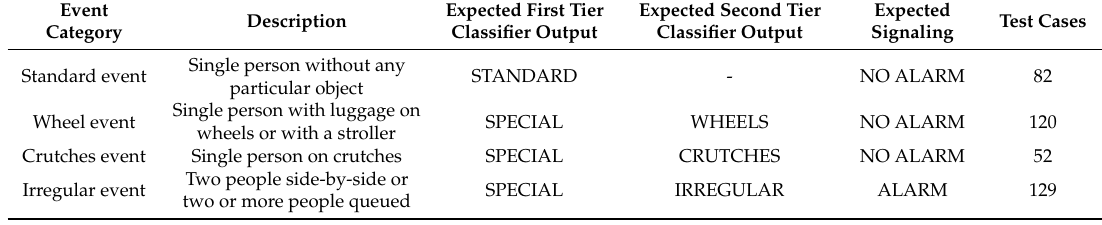
11 of 20 Figure 7. Trajectories and applied forces with respect to time: case of a person pulling a luggage on wheels. ( a ) 𝑋 and 𝑌 coordinates for each footboard; ( b ) vertical force resultant magnitude for each